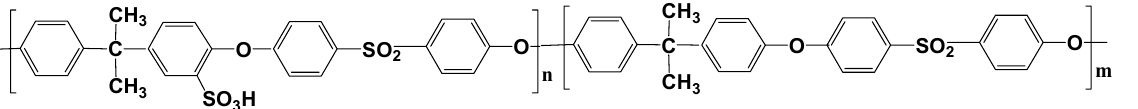
Figure 1. Structural formula of sulfonated polysulfone (SPSFH).